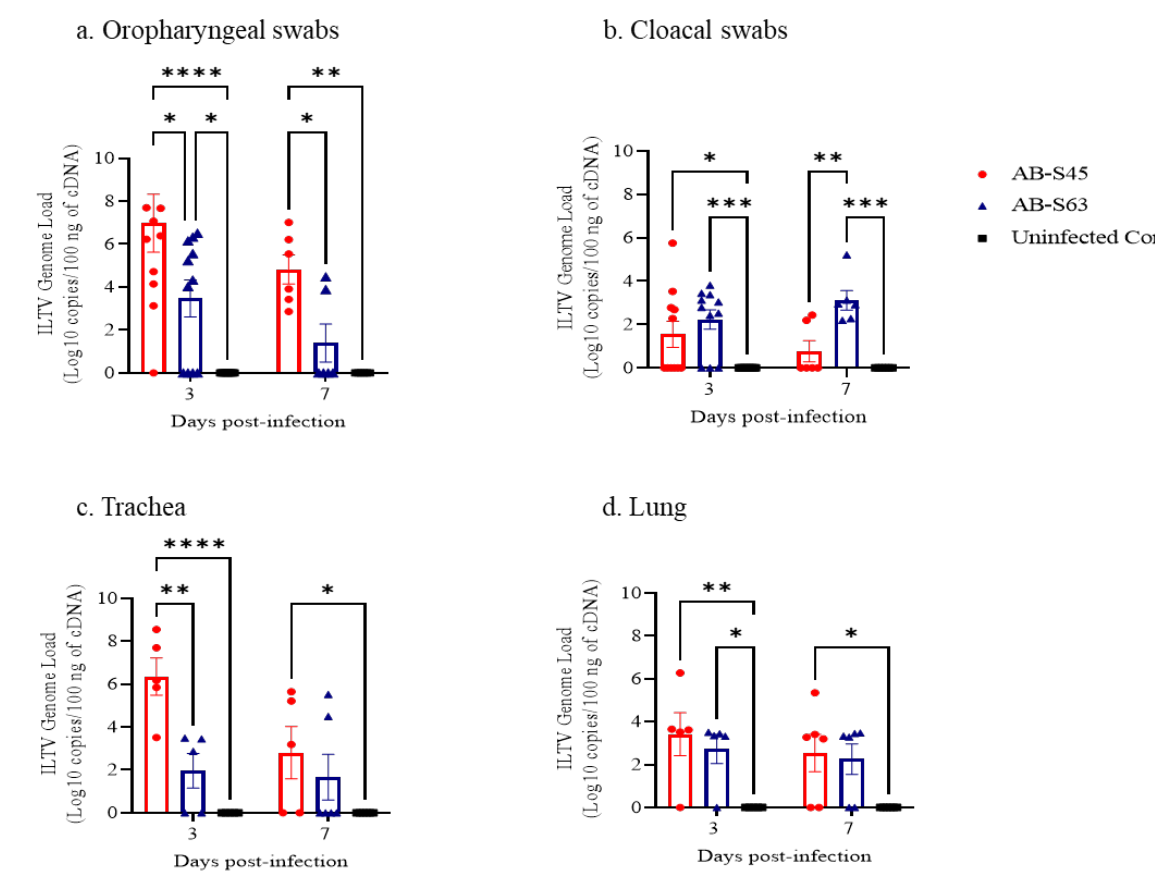
Figure 2. The ILTV genome loads at 3 and 7 dpi following infection with wildtype (AB-S63) and CEO vaccine revertant (AB-S45) ILTV isolates. ILTV genome loads in ( a ) oropharyngeal swabs; ( b ) cloacal swabs; ( c ) lung; and ( d ) trachea are illustrated. The Kruskal–Wallis test, followed by Dunn’s multiple comparison test, was employed to identify group differences in ILTV genome load. The error bars indicate the SEM. * p < 0.05, ** p < 0.01, and *** p < 0.001, **** p < 0.0001 .